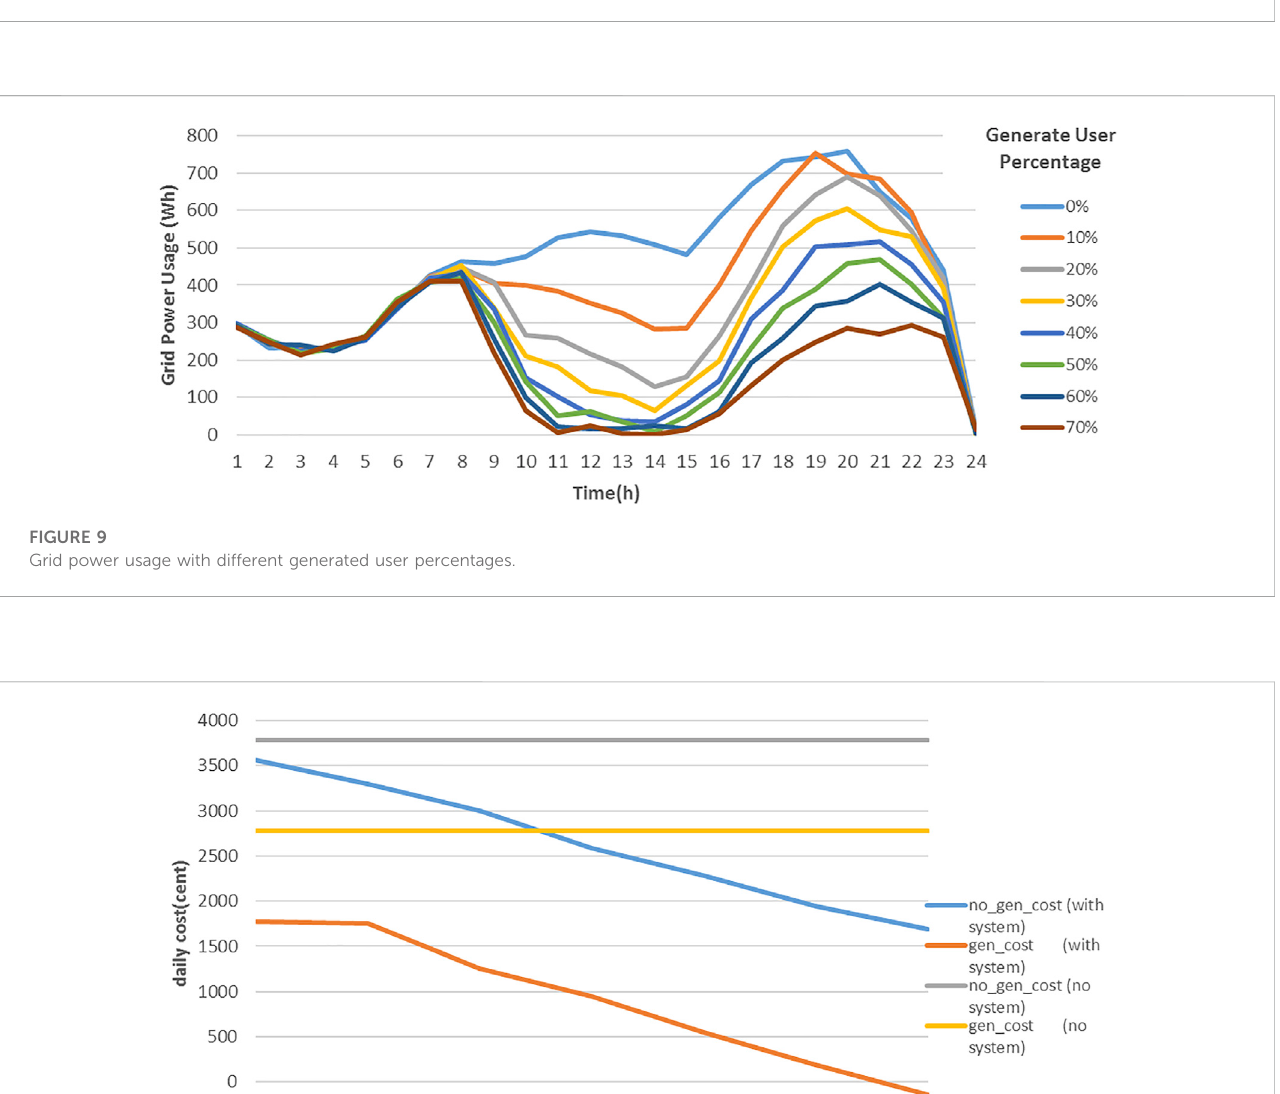
FIGURE 8 User power needs with different generated user percentages.